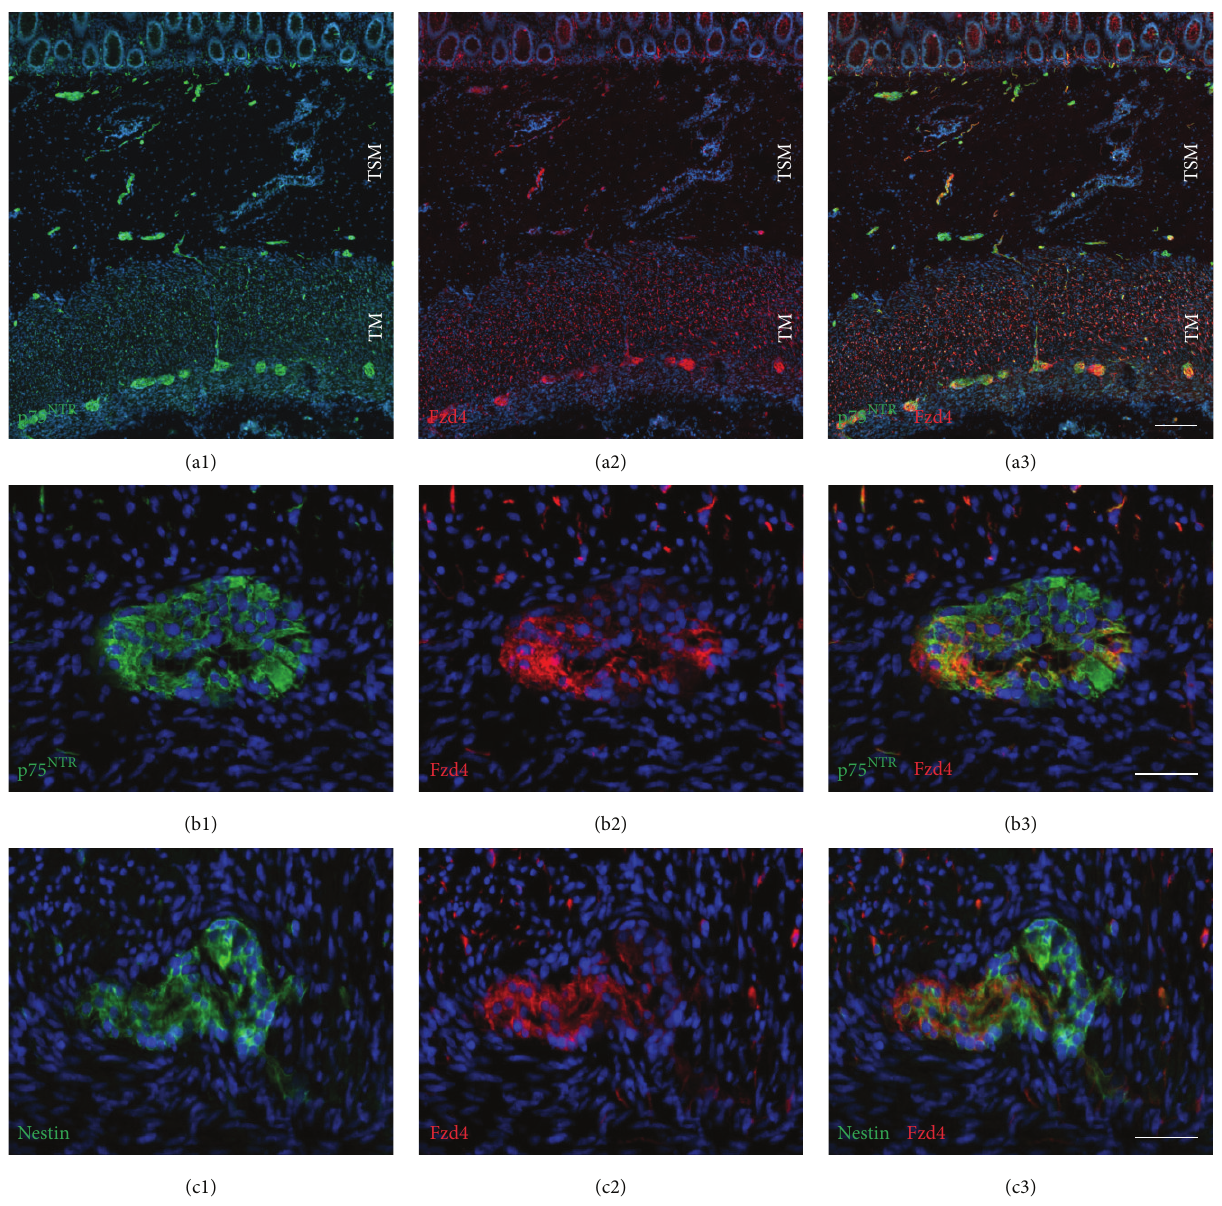
Figure 1: The Wnt receptor frizzled-4 is expressed in neural cells in all layers of the gut wall. Immunohistochemical analysis for frizzled-4 (Fzd4), p 75 NTR , and nestin expression on cryostat sections of human colon (sample number 1). ((a1)–(a3)) Overview of combined p 75 NTR (green) and Fzd4 (red) immunostaining; p 75 NTR (a1); Fzd4 (a2); merge (a3); DAPI (blue); tunica muscularis (TM); tela submucosa (TSM); scale bar: 200 𝜇 m. ((b1)–(b3)) Higher magnification of combined p 75 NTR (green) and Fzd4 (red) immunostaining of myenteric ganglia; p 75 NTR (b1); Fzd4 (b2); merge (b3); DAPI (blue); scale bar: 50 𝜇 m. ((c1)–(c3)) Combined nestin (green) and Fzd4 (red) immunostaining of myenteric ganglia; nestin (c1); Fzd4 (c2); merge (c3); DAPI (blue); scale bar: 50 𝜇